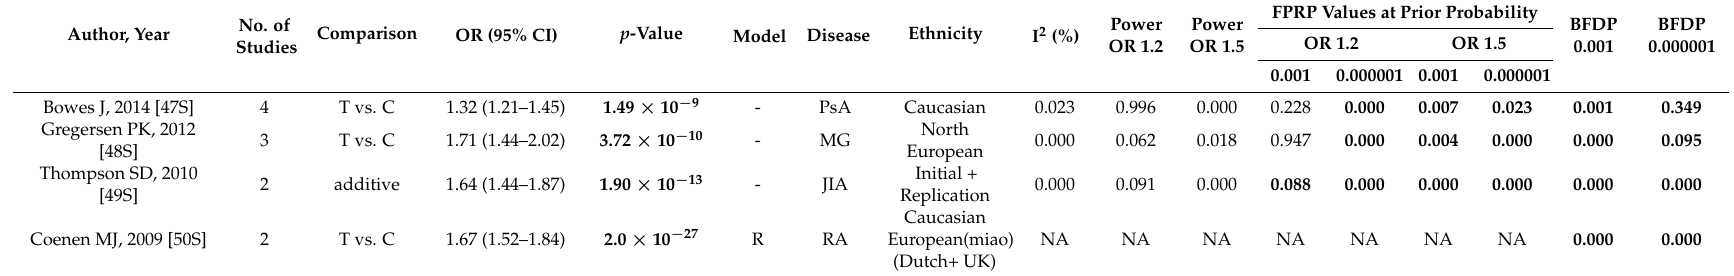
Table 8. Meta-analysis results of gene variants from genome-wide association studies showing significant p -value (<5 × 10 − 8 ).